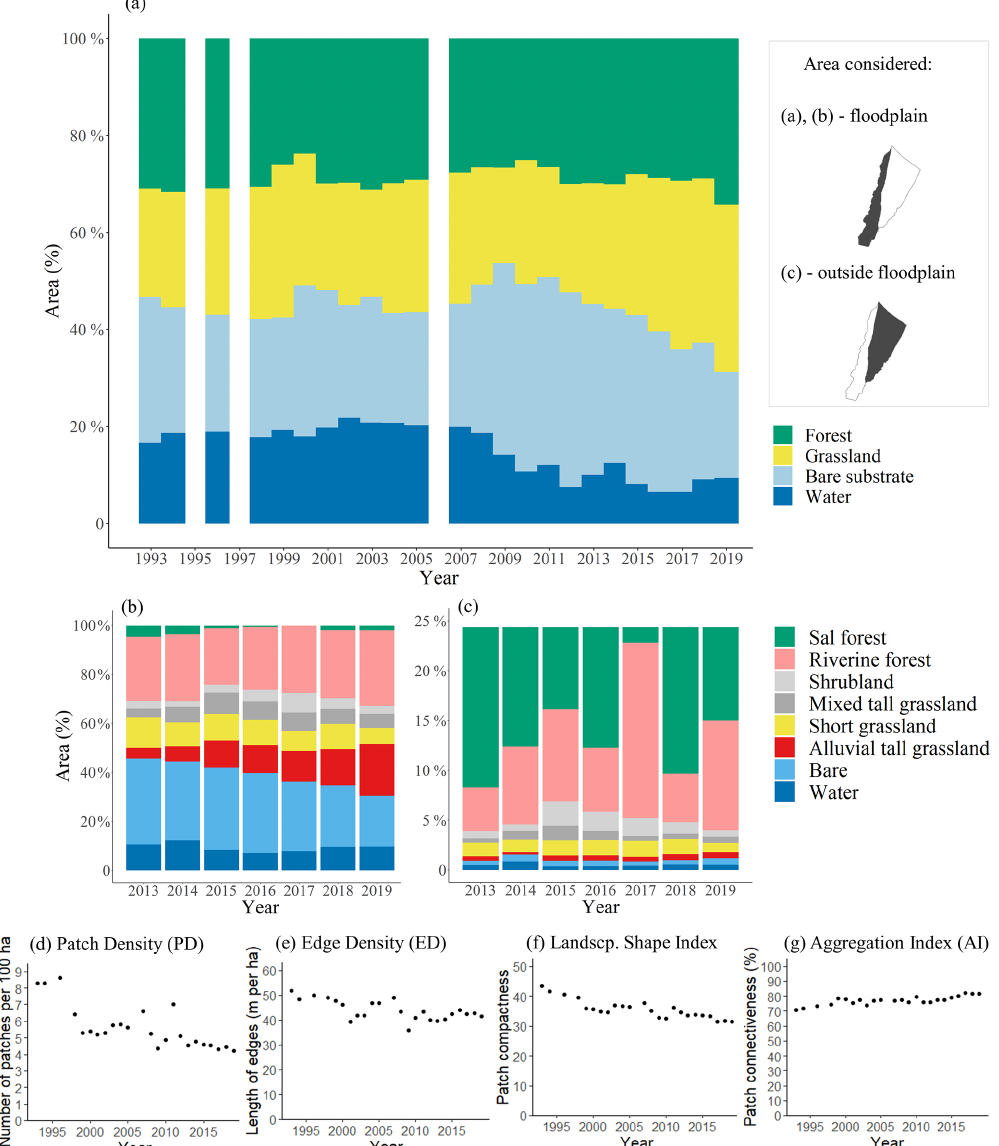
Figure 4. The temporal changes in land cover classes and pattern from the (a) level 1 dataset and (b, c) level 2 dataset. White columns represent years with no data. Water can be interpreted as average water cover during the dry season. Note that a maximum of 25% was set in (c) for the surface area outside the floodplain for visualization purposes; the remaining 75% of the area consists solely of Sal forest. (d, e, f, g) Landscape fragmentation metrics (Table 2) through time for the grassland class in the floodplain, derived from the level 1